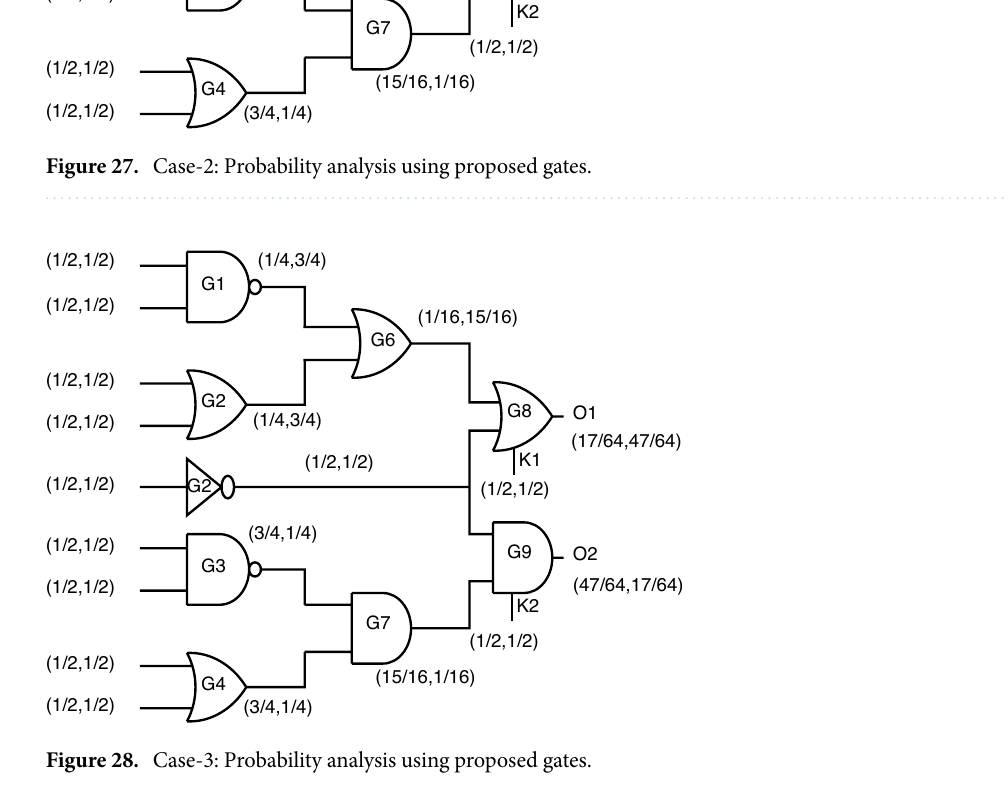
Figure 28. Case-3: Probability analysis using proposed gates.